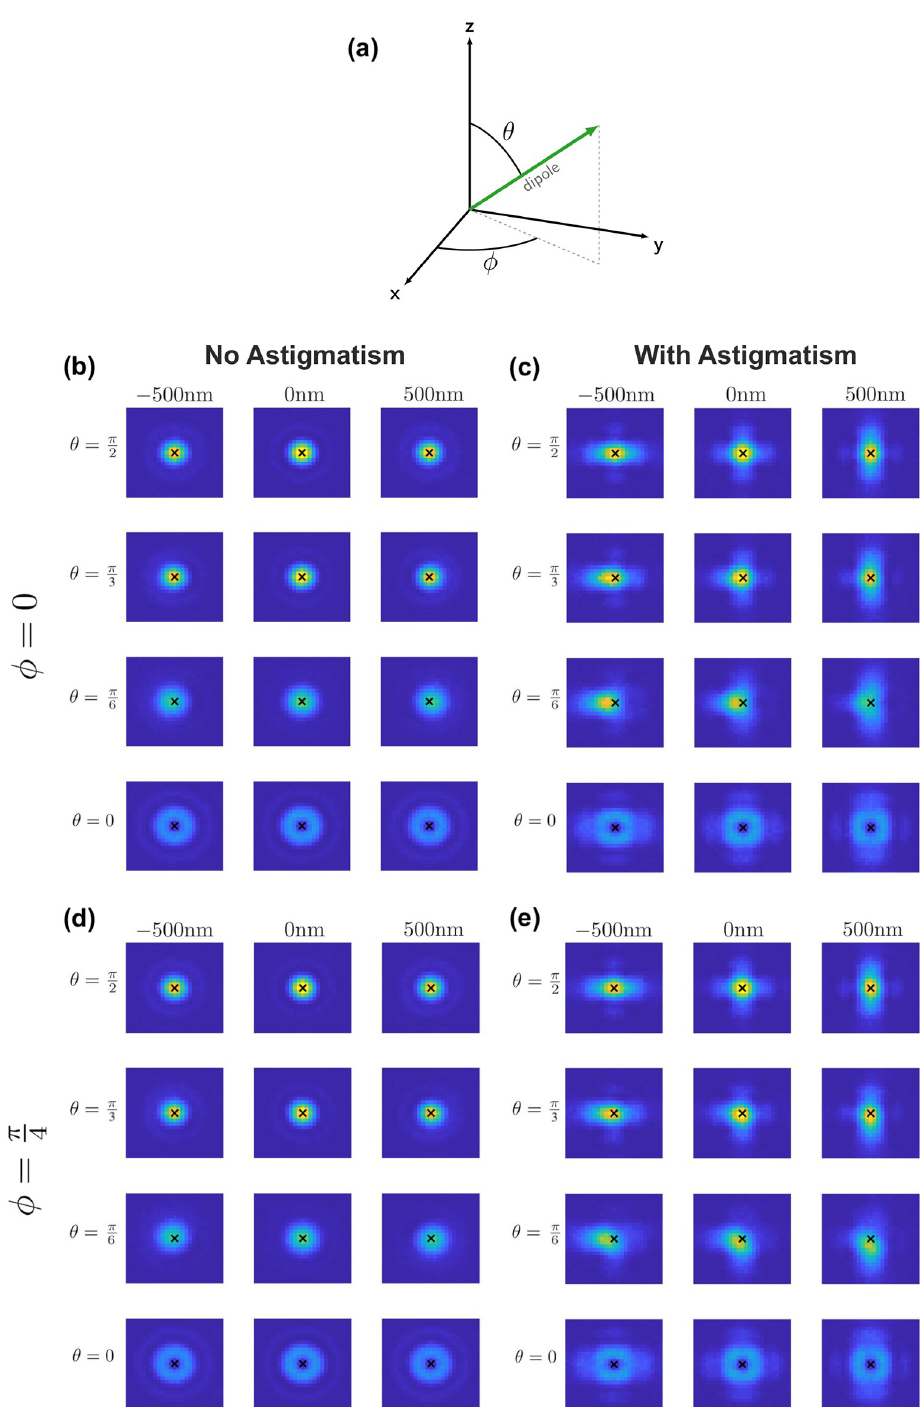
Fig 1. PSFs for different dipole orientations. (a) Illustrative dipole orientation with azimuthal angle ϕ and inclination angle θ . The optical axis is assumed to be parallel to the z -axis. PSF intensity patterns with no astigmatism (b,d) and 75 nm RMS vertical astigmatism (c,e). The inclination angle is set to θ = π /2, π /3, π /6, 0 and the azimuthal angle is ϕ = 0 (b,c) and ϕ = π /4 (d,e). The black cross indicates the actual position of the dipole emitter.